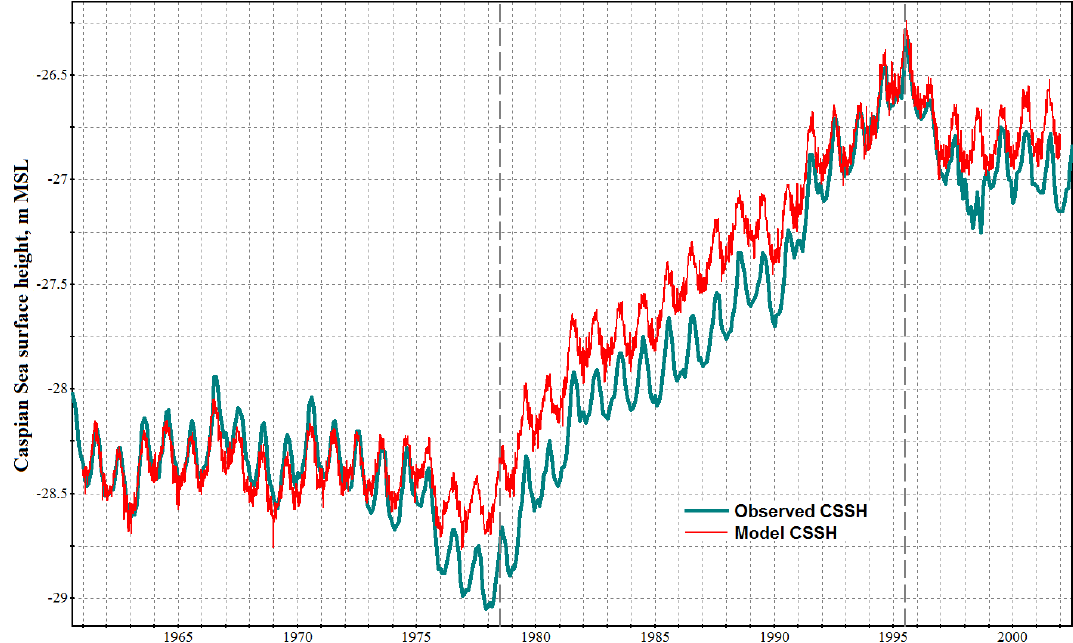
Figure 5. Caspian Sea surface height (CSSH) in the vicinity of Baku: observations and model reconstruction (in meters relative to mean sea level;